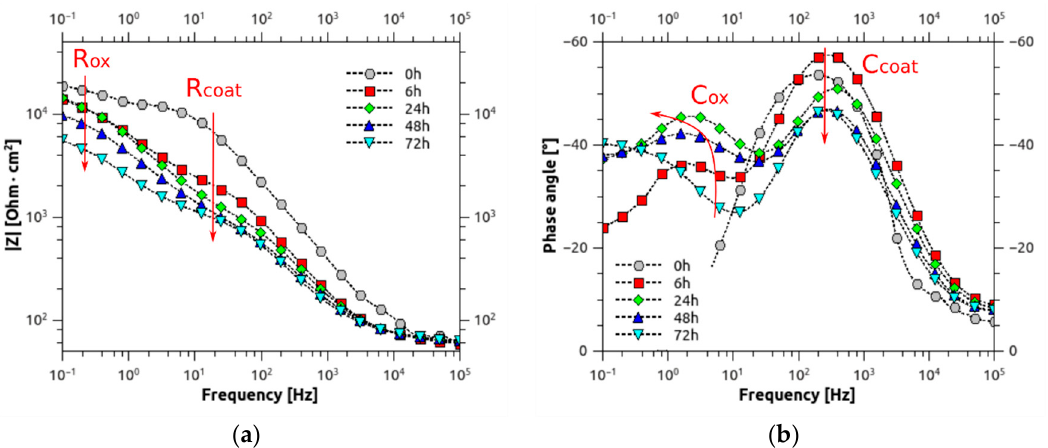
Figure 8. Bode plot of impedance modulus ( a ) and phase angle ( b ) of AS3-CNT6 batch at increasing immersion time.